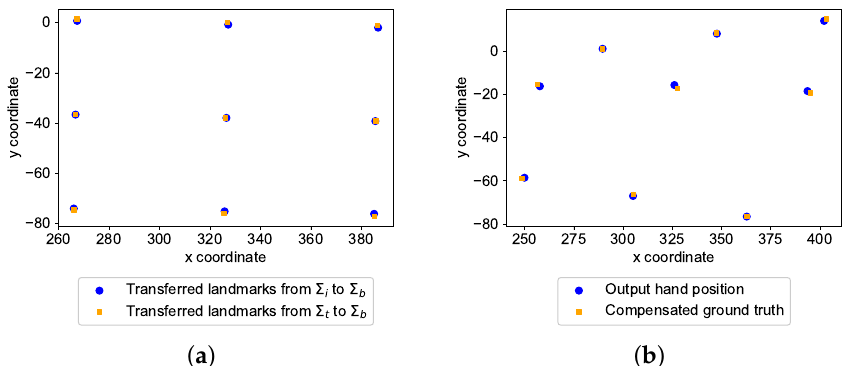
Figure 6. ( a ) Transferred landmarks from Σ i to Σ b and Σ t to Σ b using optimized parameters, respec- tively. ( b ) Output hand positions using Equation (8) with optimized parameters and compensated ground truth using Equation (20).